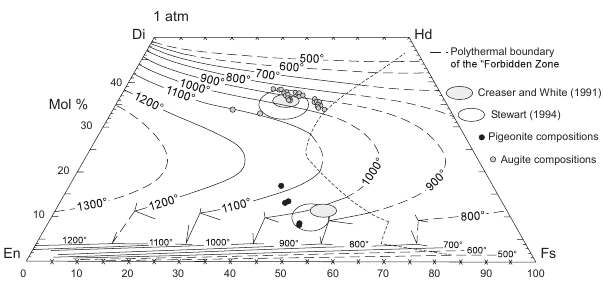
Fig. 3. Graphical pyroxene geothermometer after Lindsley (1983). Pigeonite and augite data from Creaser and White (1991), Stew- Figure 3. Pankhurst et al. art (1994) and this study indicate magmatic temperatures between 900 ◦ C and 1110 ◦ C for the upper Gawler Range